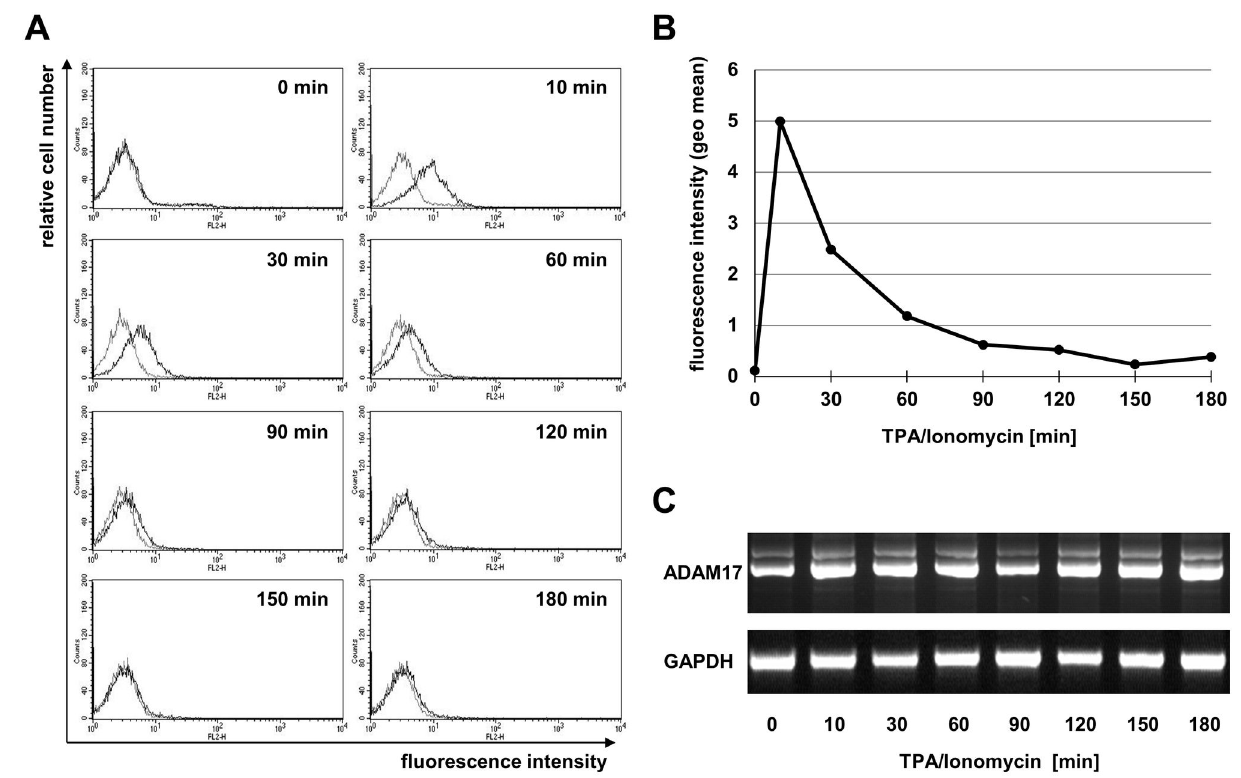
Figure 7. ADAM17 alterations in stimulated PHA blasts. PHA-activated T cell blasts were stained for ADAM17 at the indicated time points after stimulation with TPA and Ionomycin using mAb A300E. A. Histograms for individual data points document the rapid and transient induction of surface ADAM17. B. Visualization of ADAM17 kinetics based on the calculation of geometric mean values from individual histograms shown in A.C. The RT-PCR analyses for ADAM17 and GAPDH as a control performed on samples obtained in parallel at the indicated time points did not reveal any indication for changes at the level of